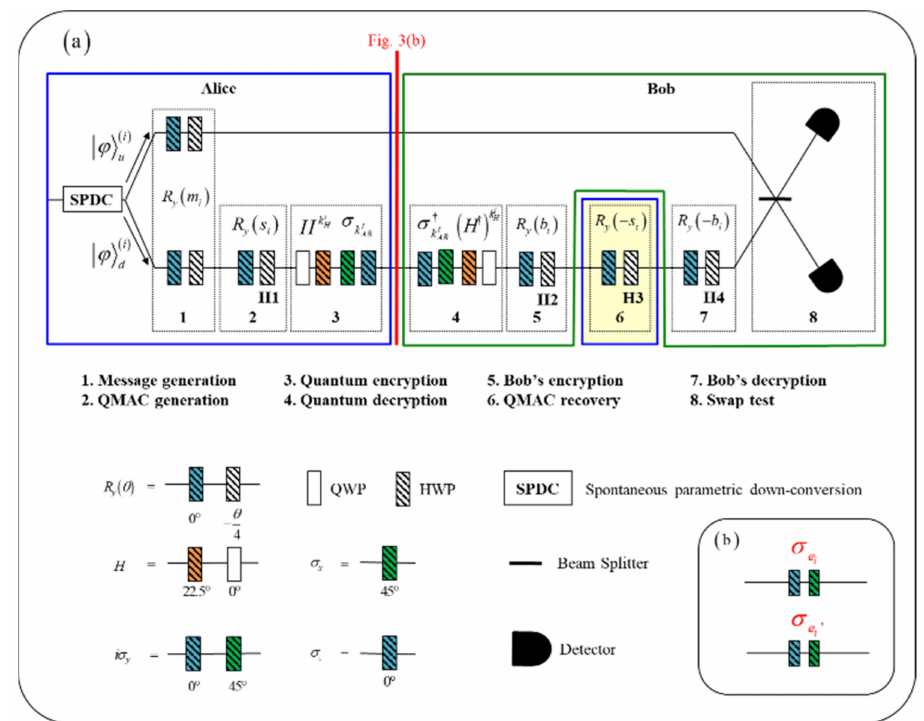
Figure 3. Schematic representation of the experimental setup for the quantum message authentication protocol and an existential forgery. ( a ) Quantum message authentication protocol: the blue box represents Alice’s operation, and the green box represents Bob’s operation. m i is the rotation angle that indicates message. k i ( b ) Existential forgery: Eve can attempt forgery on the quantum message authentication code (QMAC) state pair using Pauli operators when Alice transmits the encrypted QMAC state pair to